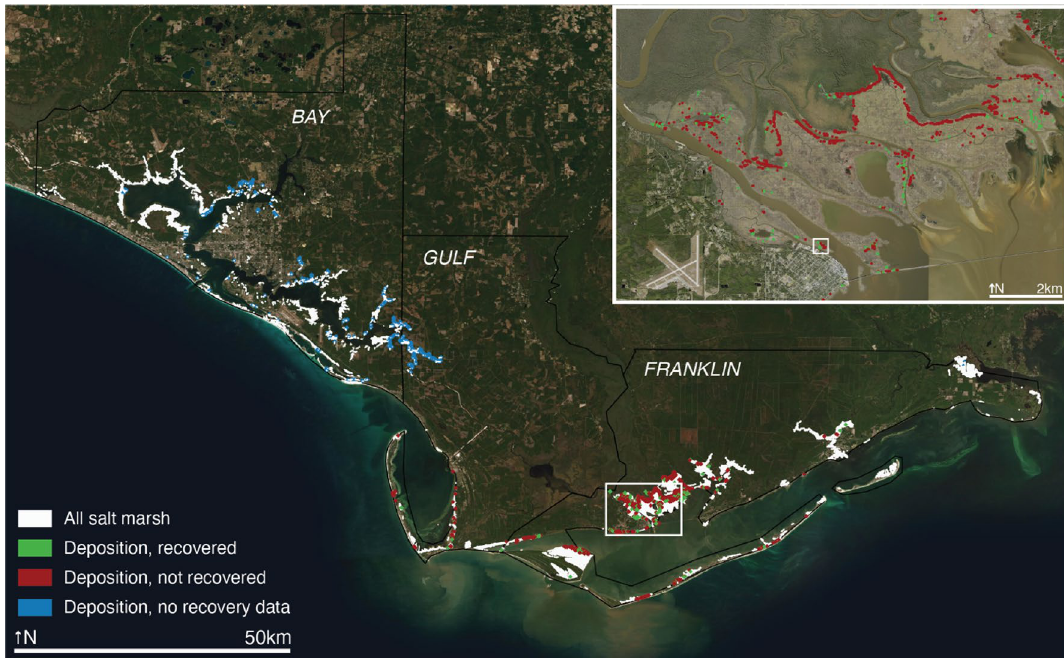
Figure 5. Map of deposition in study area. Areas of deposition of sediment or vegetation are indicated by green if recovered by April 2019, red if not recovered by April 2019, and blue if no recovery data. Grid cells with deposition are enlarged to show extent, not scale. Salt marsh area is indicated with white. Location of Fig. 2b indicated with white outline in inset map. Map created with QGIS version 3.18.3. Basemap sources: ESRI,